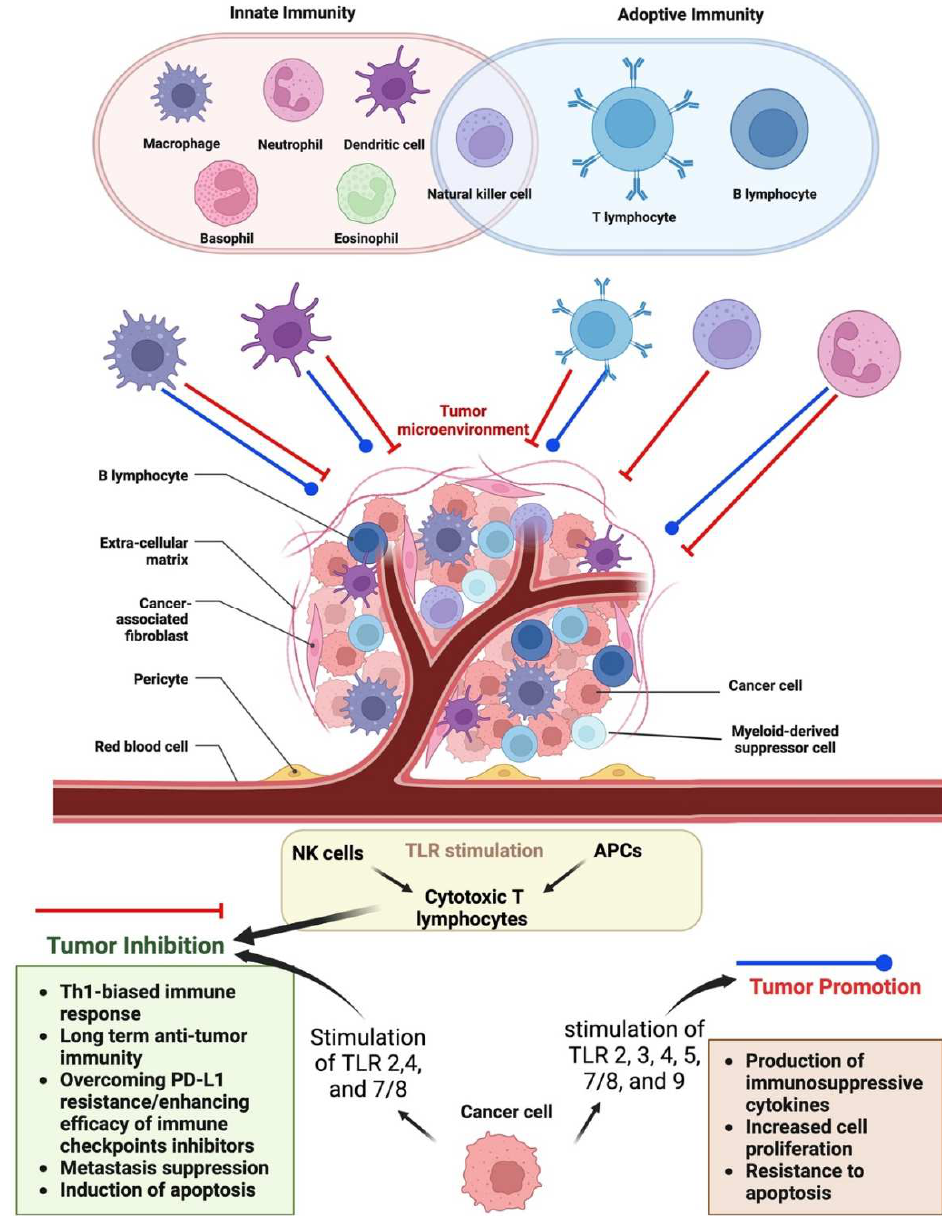
Figure 1. The innate/adaptive immunity and interaction of immune cells in a tumor with the mechanisms of inhibition and promotion.